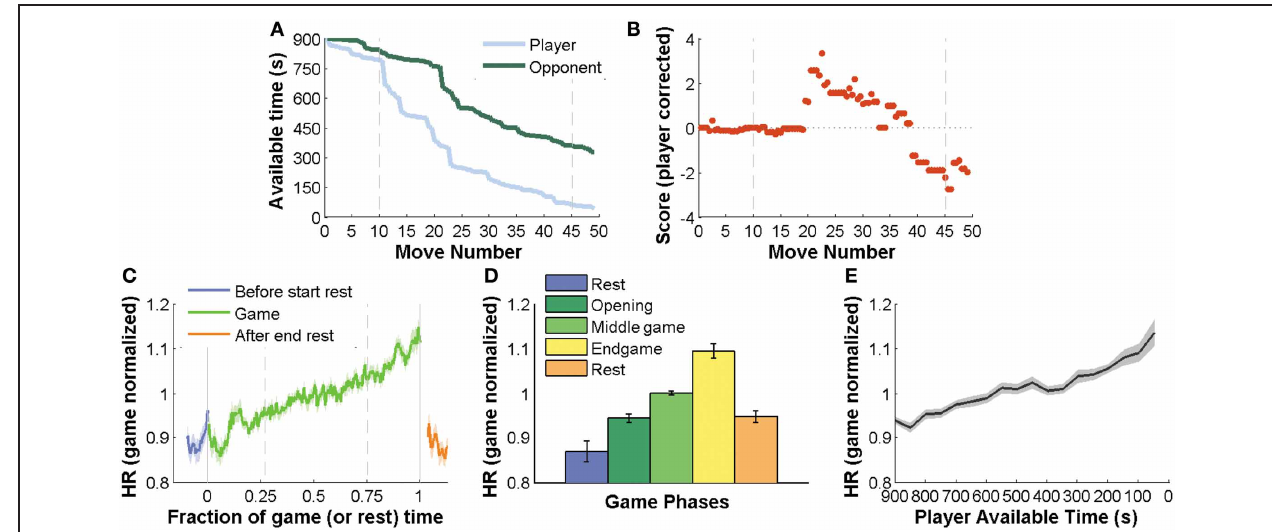
FIGURE 1 | HR correlates with game state variables. Main chess variables: player and opponent available time (AT), game phase and score. Game advance is represented by move number. For each move number there are two movements: one of the player and other of the opponent. (A) Player and opponent AT throughout a typical game. AT starts at 900s (the budget for all the games in this experiment were 15min per player) and decreases continuously. First it decreases slowly (opening moves are played fast) and as players devote more time to each move, AT decreases more rapidly. (B) Score progression throughout a typical game. Score is a measure of the value of each position. Positive or negative